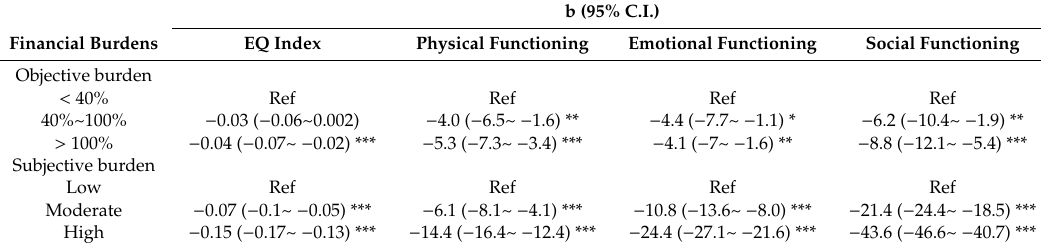
Table 4. Multivariable adjusted linear regression models of the relationship between HRQoL and financial burdens.